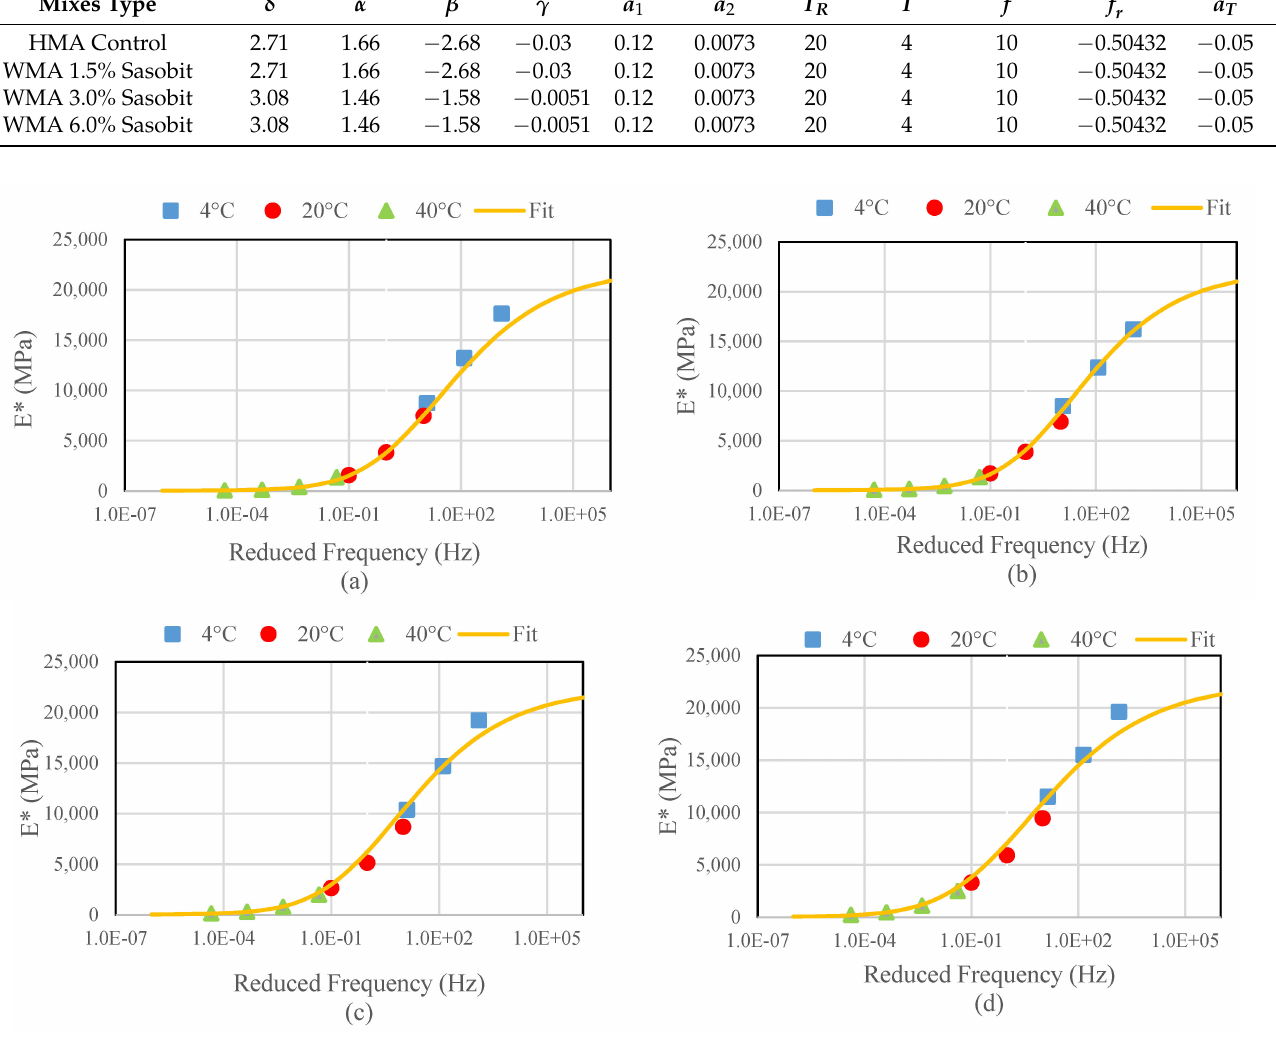
Figure 9. Master curves results: ( a ) HMA samples; ( b ) WMA with 1.5% Sasobit; ( c ) WMA with 3% Sasobit; ( d ) WMA with 6% Sasobit. Table 9. Laboratory results of WMA and HMA for dynamic